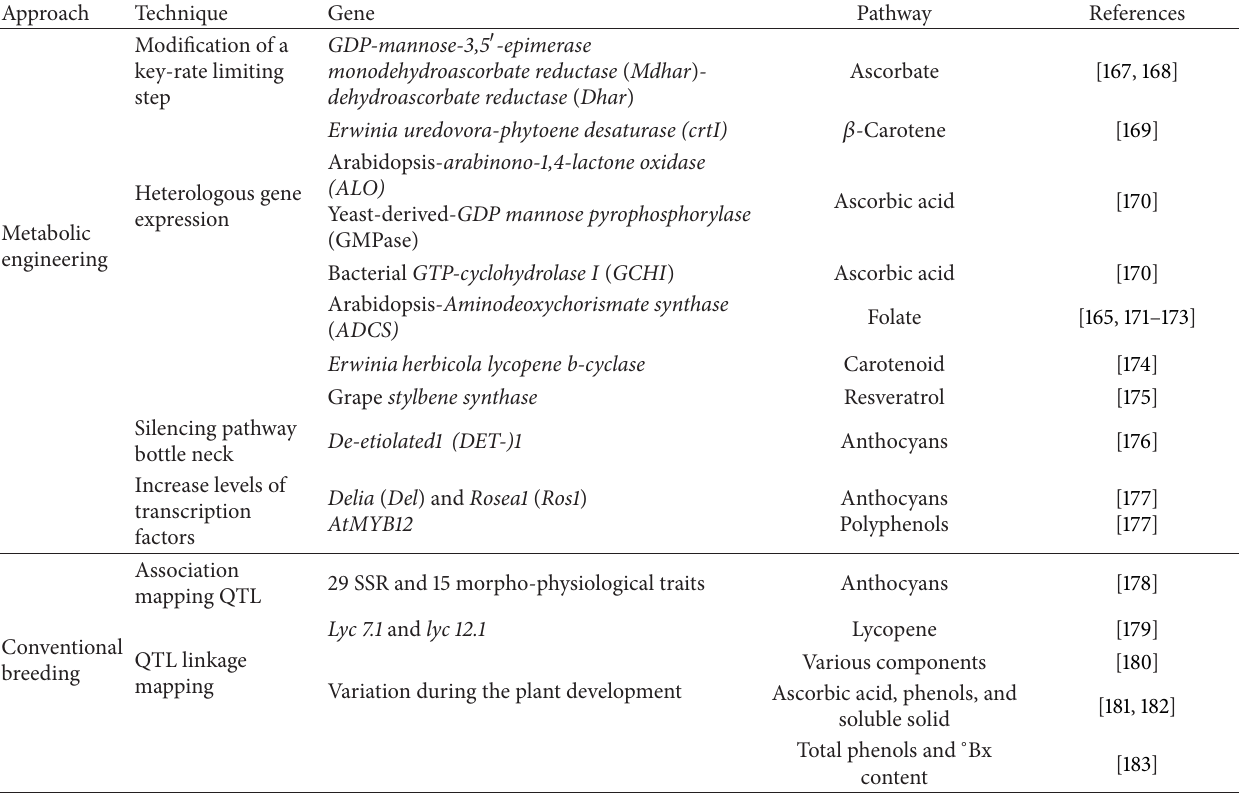
Table 3: Results of biofortification through metabolic engineering and breeding in